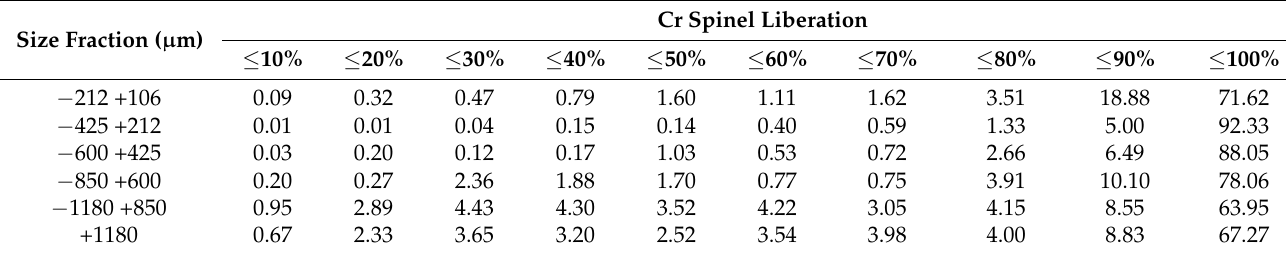
Table 6. Spinel liberation data from the QEMSCAN analysis.